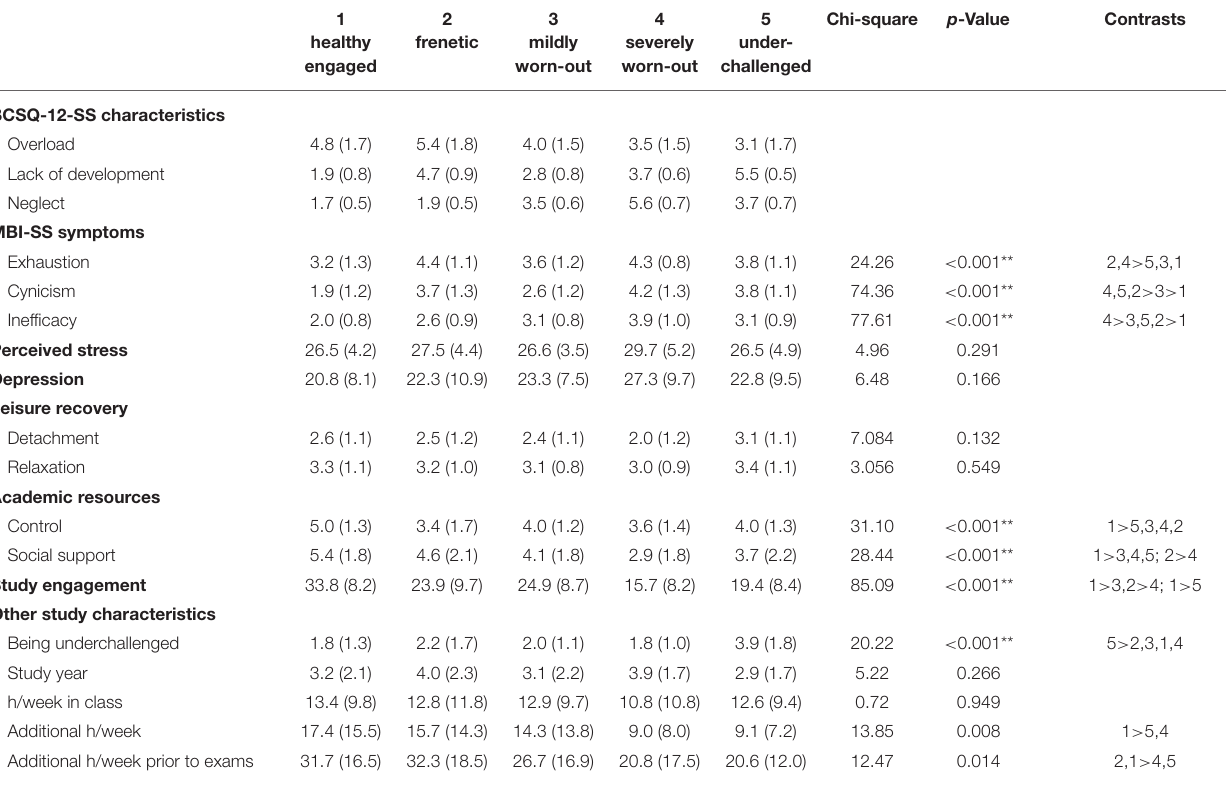
1 2 3 4 5 Chi-square p -Value Contrasts healthy frenetic mildly severely under- engaged worn-out worn-out challenged